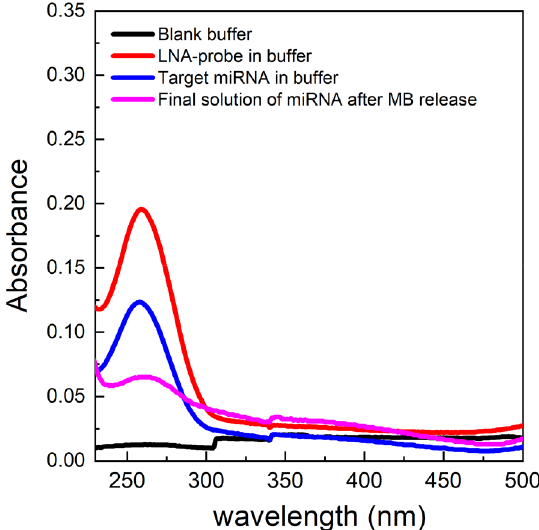
Figure 4. UV absorbance of the biotinylated LNA probe (red), target miRNA (blue), and the miRNA released from the magnetic beads (magenta) using 1 M NaOH. Buffer was set as the baseline measurement (black line) of the spectrophotometer prior to UV analysis. The absorbance levels below 230 nm were considered to be noise due to the increased absorbance of the quarts cuvette itself upon being subjected to light at wavelengths lower than 250 nm.